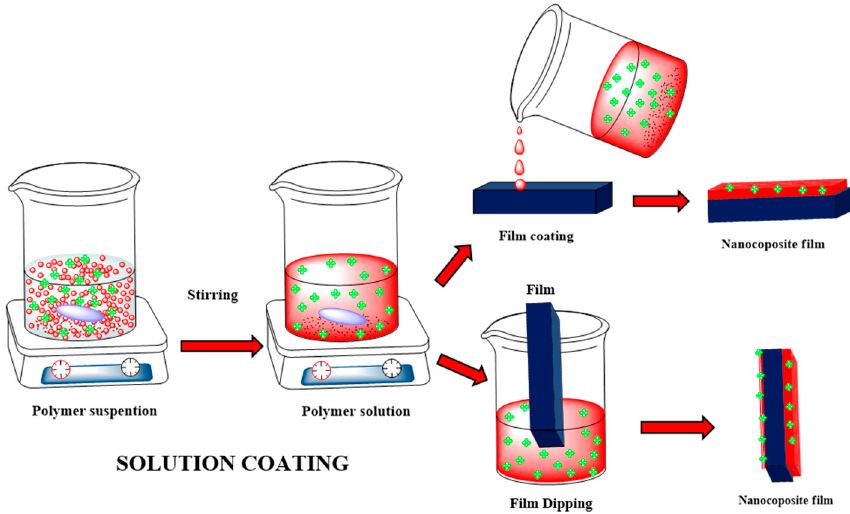
Figure 2. Fabrication of NCM by solution coating method.